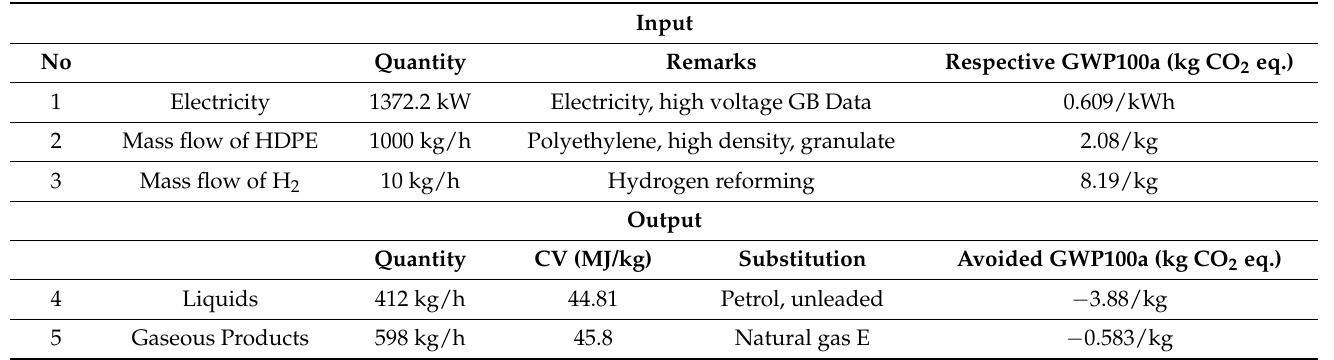
Table 14. Inventory for the hydrocracking process per functional unit based on the simulation